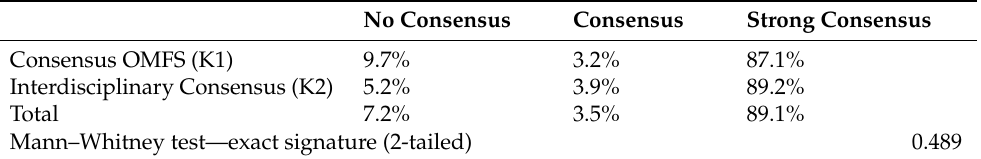
Table 6. Strength of